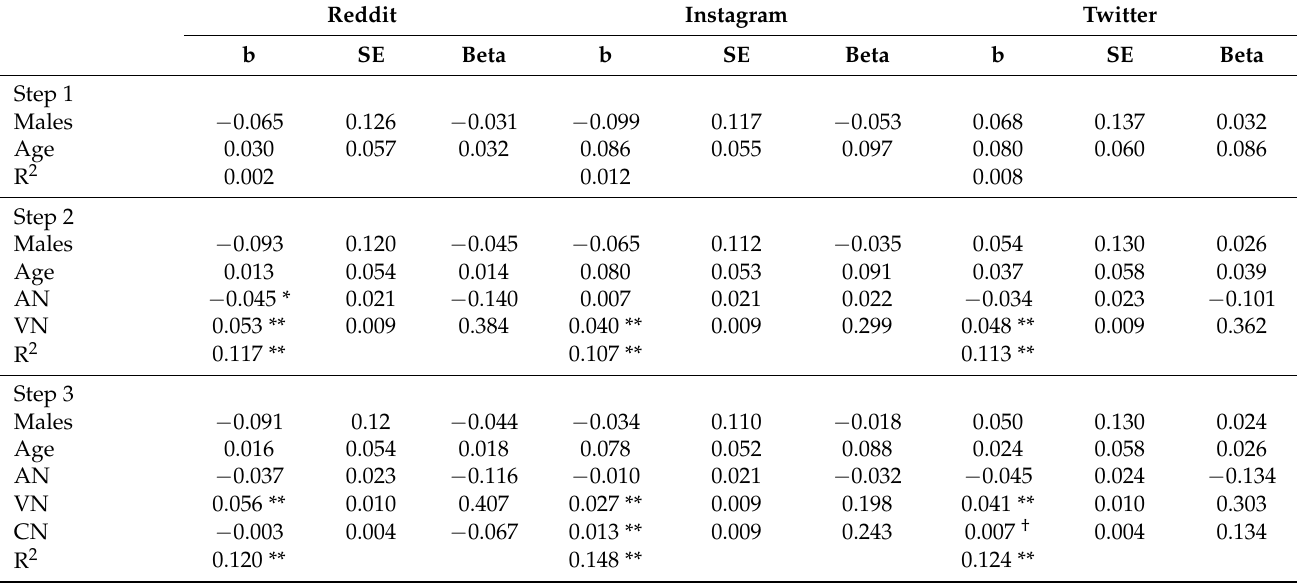
Table 3. Multiple linear regression predicting frequency of social media use for Reddit, Instagram and Twitter, showing unstandardized coefficients (b), standard errors (SE) and standardized coefficients